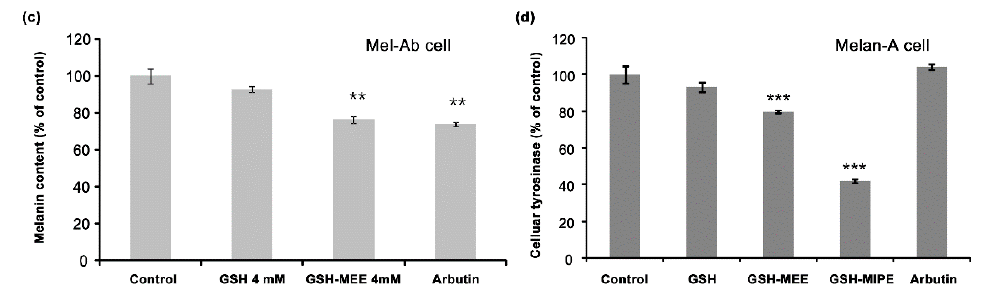
Figure 2. ( a ) Effect of GSH derivatives on melanin content in Melan-A cells. GSH exhibited no inhibitory effect on melanin production, but GSH-MEE and GSH-MIPE decreased the melanin synthesis in Melan-A cells. Arbutin (100 µg/mL) was treated to serve as a positive control. The melanin content was calculated by normalizing the melanin content to total cellular protein and reported as a percentage of control. Data are shown as the mean ± SD of three replicates, and ** p < 0.01, and *** p < 0.001. GSH, reduced glutathione; GSH-MEE, GSH monoethyl ester; GSH-MIPE, GSH monoisopropyl ester; SD, standard deviation; ( b ) The effect of GSH on melanin production in Melan-A cells. GSH had no inhibitory effect on melanin production in Melan-A cells. Each sample was quantified with the same amount of protein and reported as a percentage of control. Data are shown as the mean ± SD of three replicates; ( c ) Effect of GSH and GSH-MEE on melanin content in Mel-Ab cells GSH had no inhibitory effect on melanin production, but GSH-MEE decreased the synthesis of melanin significantly in Mel-Ab cells. Arbutin (100 µg/mL) was treated as a positive control. The melanin content was calculated by normalizing the melanin content to total cellular protein and reported it as a percentage of control. Data are shown as the mean ± SD of three replicates, and ** p < 0.01; ( d ) the effect of GSH derivatives on intracellular tyrosinase activity in Melan-A cells. GSH had no significant effect on intracellular tyrosinase activity, but GSH-MEE and GSH-MIPE decreased the activity of intracellular tyrosinase in Melan-A cells. Arbutin (100 µg/mL) was treated as a positive control. Each sample was quantified with the same amount of protein and reported as a percentage of control. Data are shown as the mean ± SD of three replicates, and *** p < 0.001.